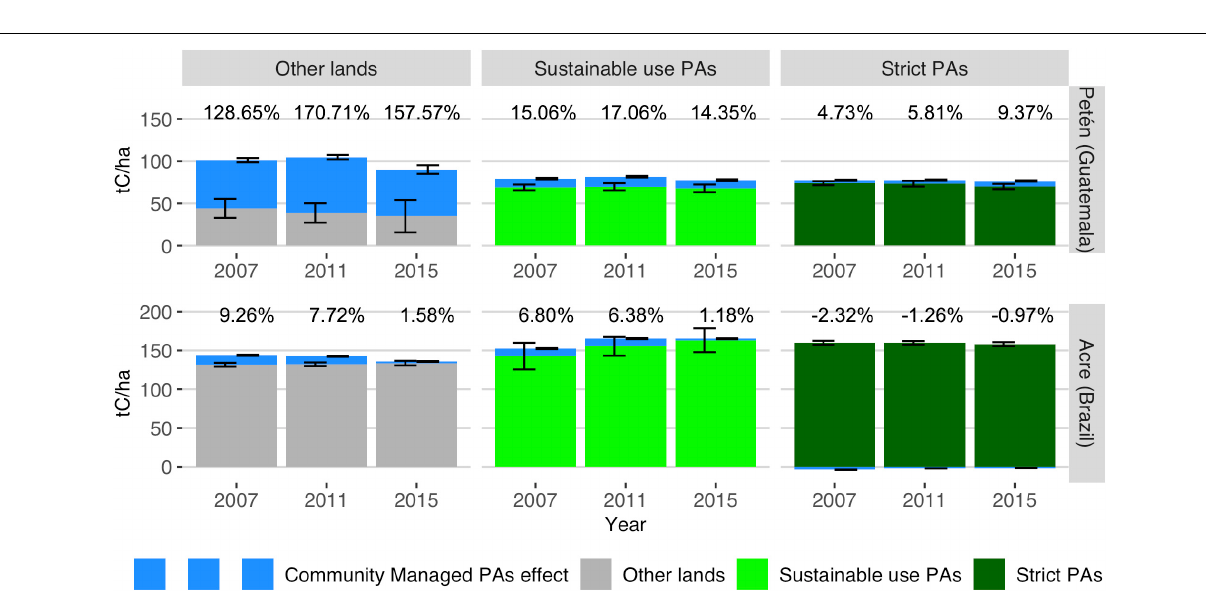
Frontiers in Forests and Global Change |